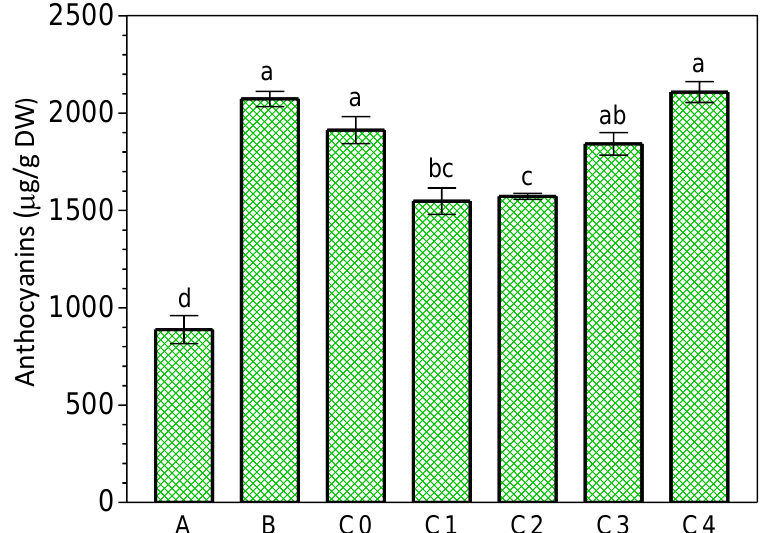
Figure 7. Anthocyanin content in K. blossfeldiana leaves on the plant (A) and in the detached leaves kept 4-day in the normal position (B) or kept 4-day in the inverted position (C). Mean results ± standard deviation followed by the same lower letter were not significantly different ( p < 0.05) ac- cording to Tukey’s test.